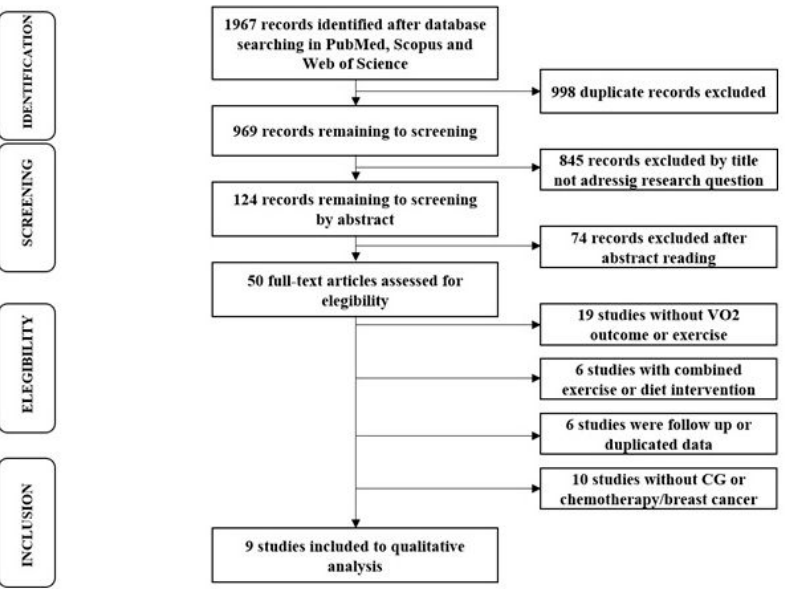
Figure 2. Flow chart of the search process.